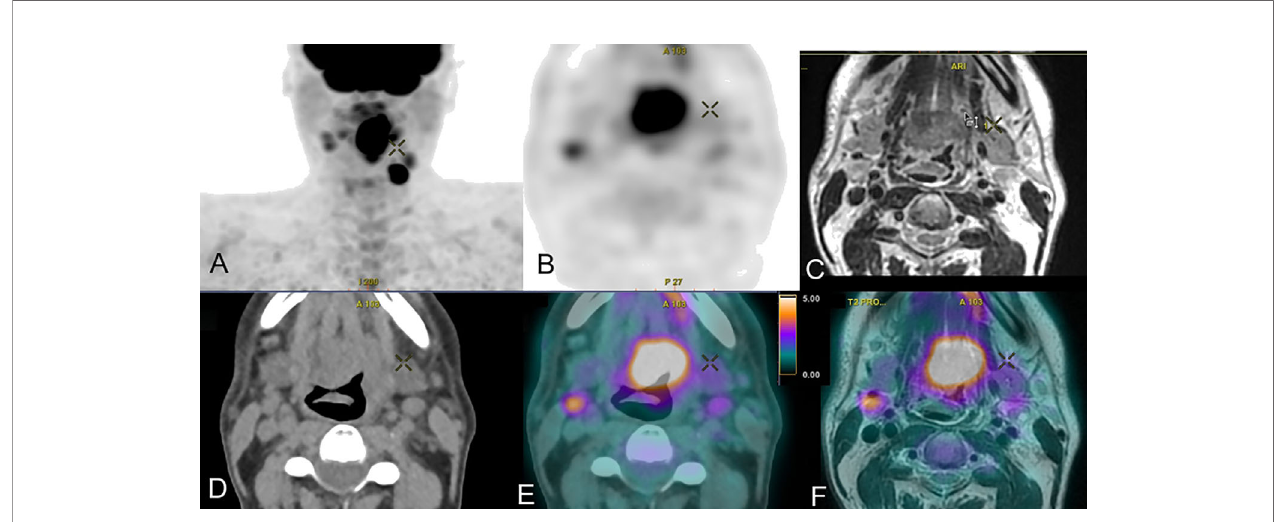
FIGURE 2 | Trimodal acquisition of a cancer of the base of the tongue with in (A) the frontal maximum intensity projection PET image, in (B) the axial PET FDG acquisition, in (C) the axial T2 MRI acquisition, in (D) the axial CT acquisition, in (E) the axial PET/CT fusion and in (F) the axial PET/MRI